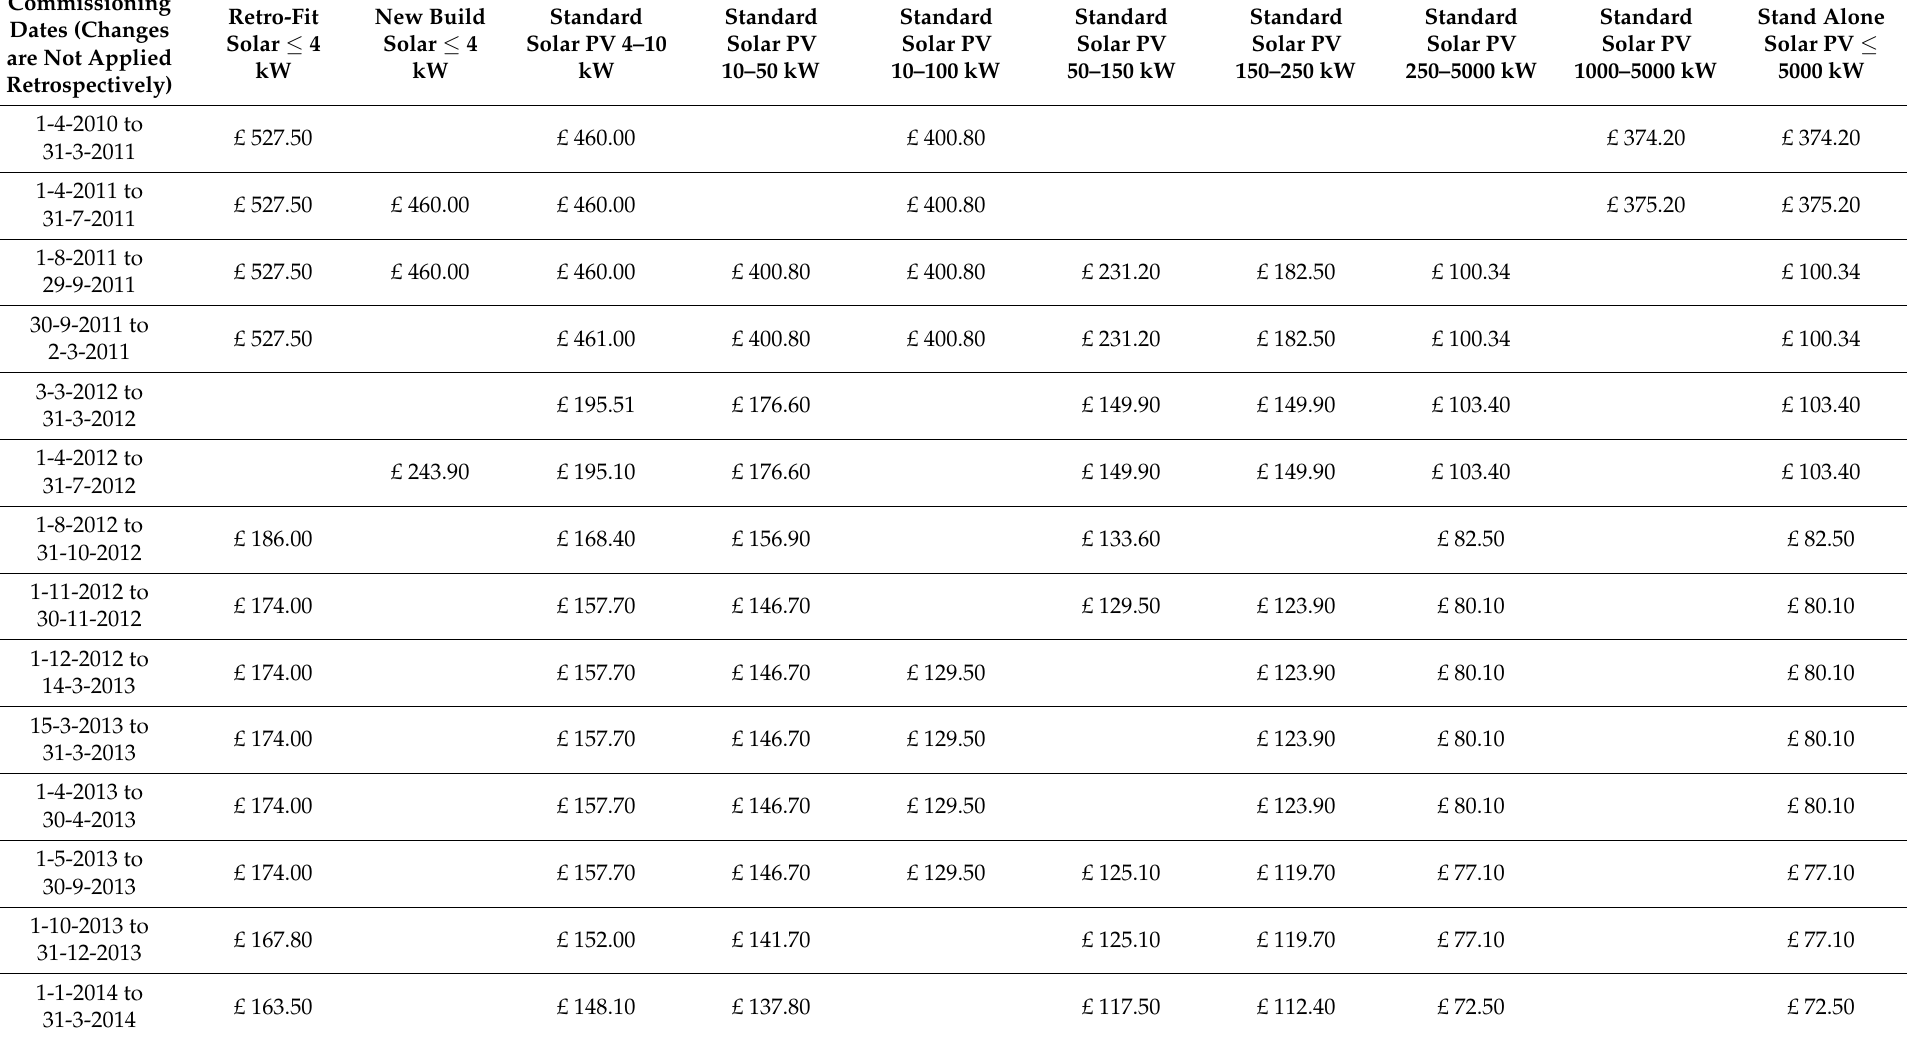
Table A2. Prices per MWh of Solar PV Generation under Ofgem FiT